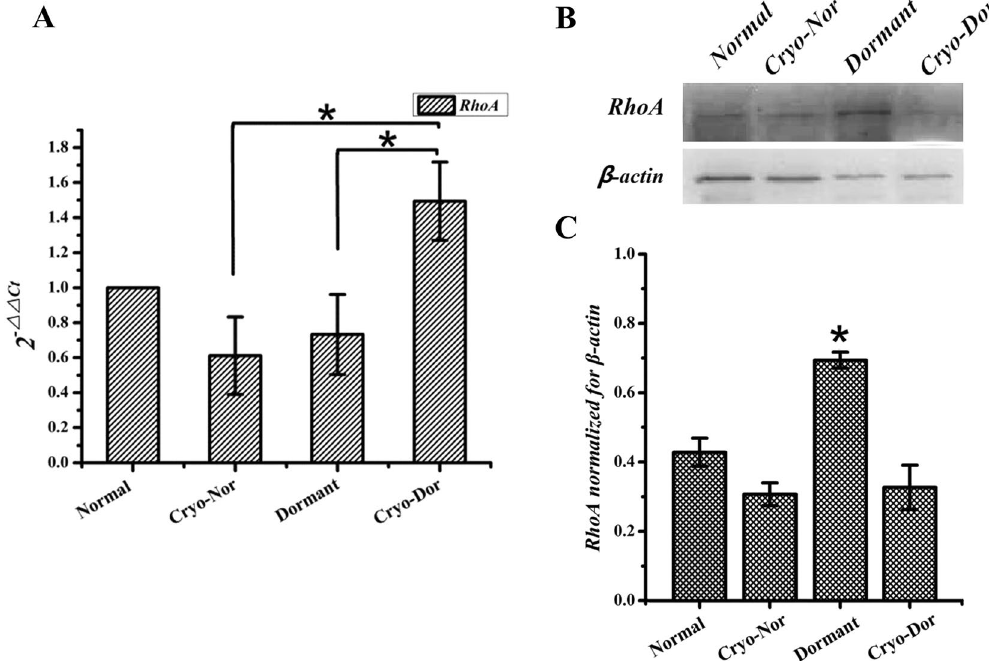
Figure 1. RhoA gene expression and Western blot analysis (cropped blots) in dormant and normally hatched embryos. ( A ) RhoA transcription was analysed in various blastocyst groups. Concentrations of RhoA mRNA were normalised to those of GAPDH . Values expressed as means ± SEM, * p < 0.05. ( B and C ) Western blot profiles of total RhoA normalized with β -actin. Values expressed as mean ± SEM, * p <